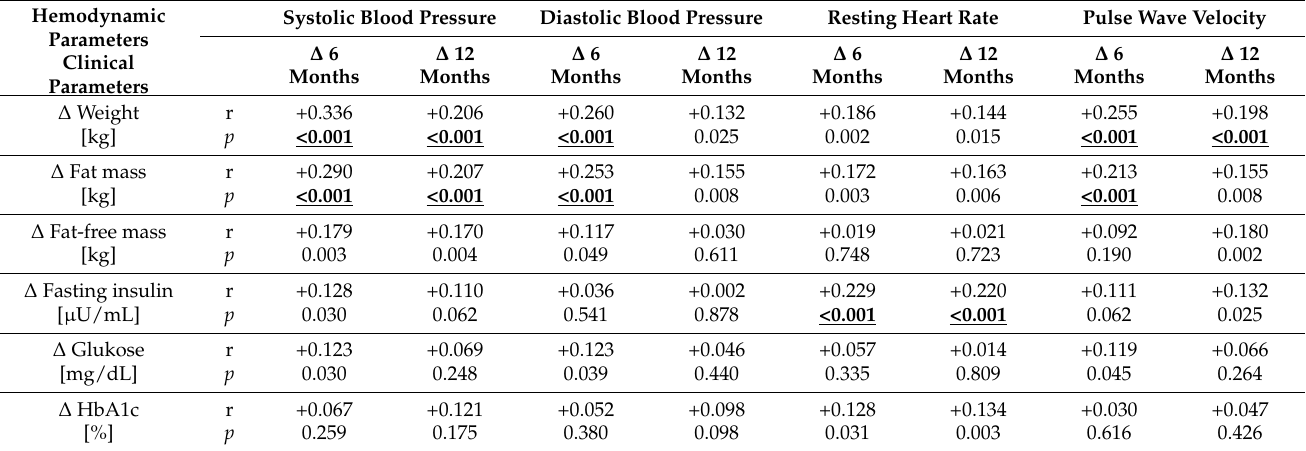
Table 3. Correlation of changes of hemodynamic and clinical parameters after 6 and 12 months of intervention from all participants completing the study ( n =